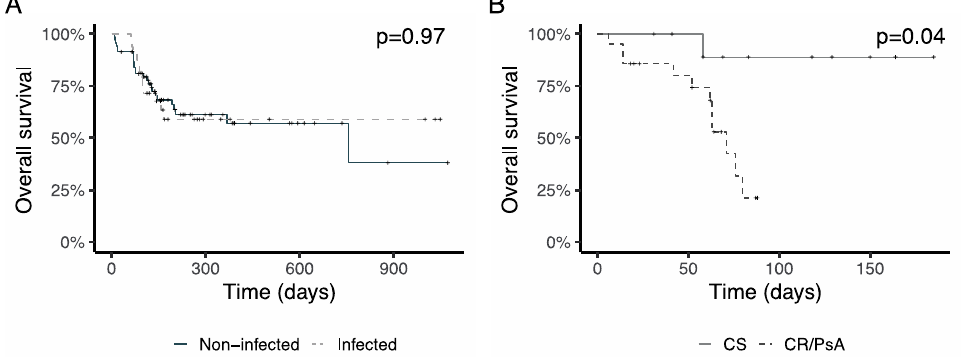
Figure 4. Impact of multiresistant Gram negative infection (MR-GNBI) on survival. ( A ) Overall survival of patients infected by a MR-GNBI compared to non-infected patients. ( B ) Mortality rate in patients infected by carbapenemase-producing K. pneumoniae (CR) or extremely resistant P. aeruginosa (PsA) compared to other carbapenem-sensitive (CS) Gram-negative infections.